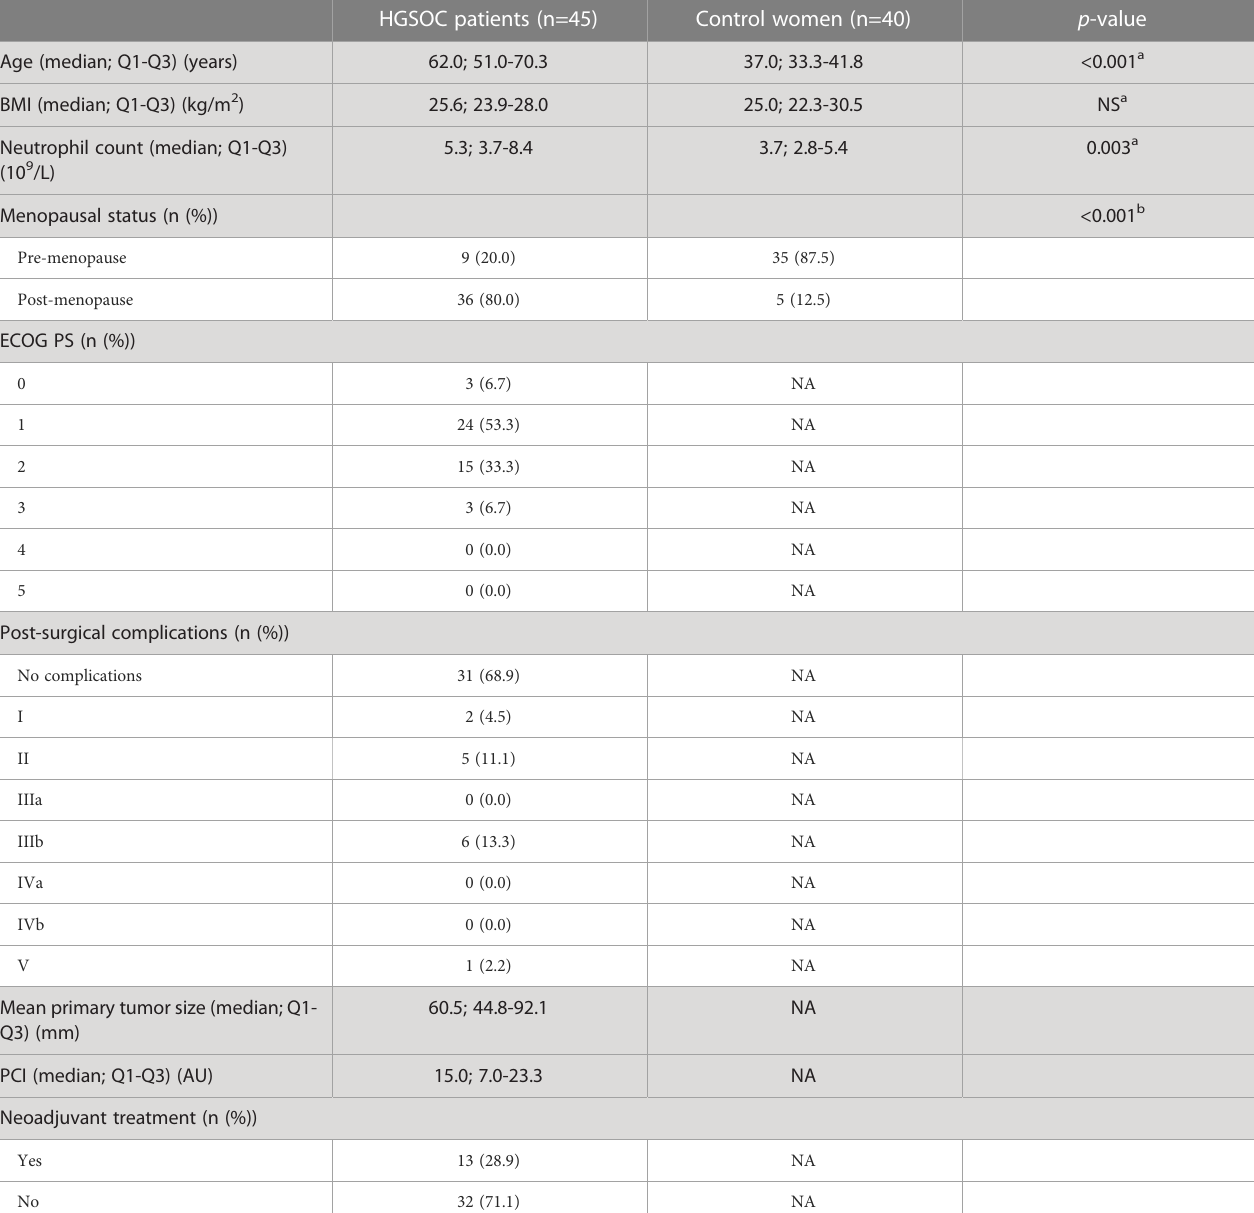
TABLE 1 Clinical-demographic characteristics of the study